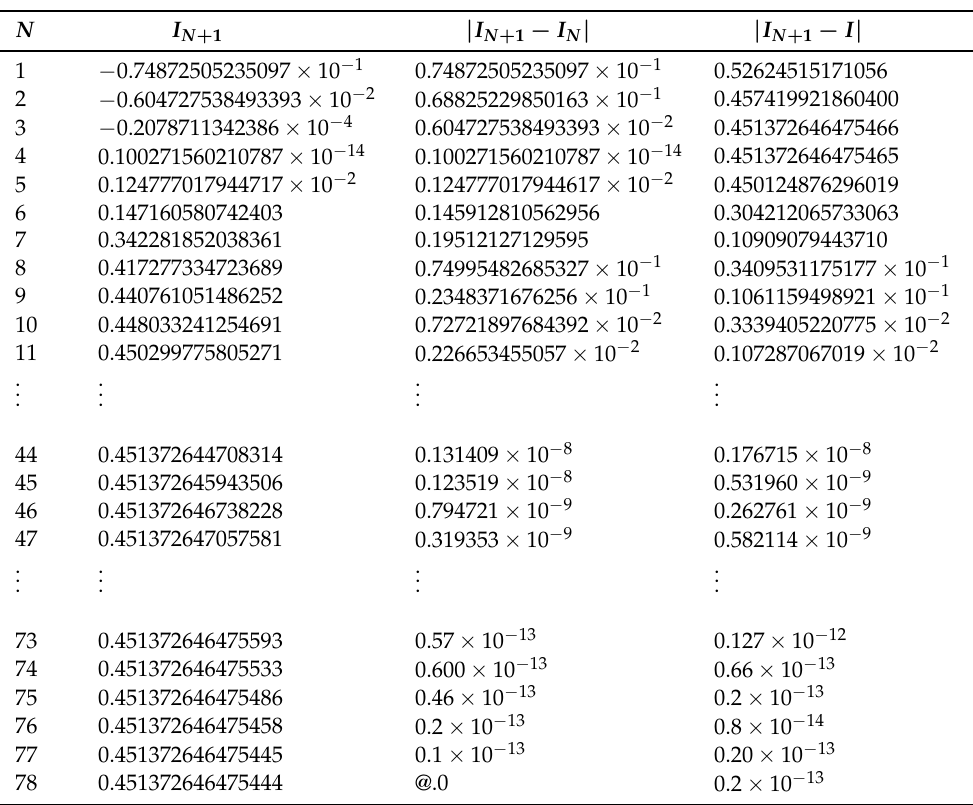
Table 6. The numerical results of the DE-Sinc integration rule to approximate the RO system based on the SA and the CESTAC method using the CADNA